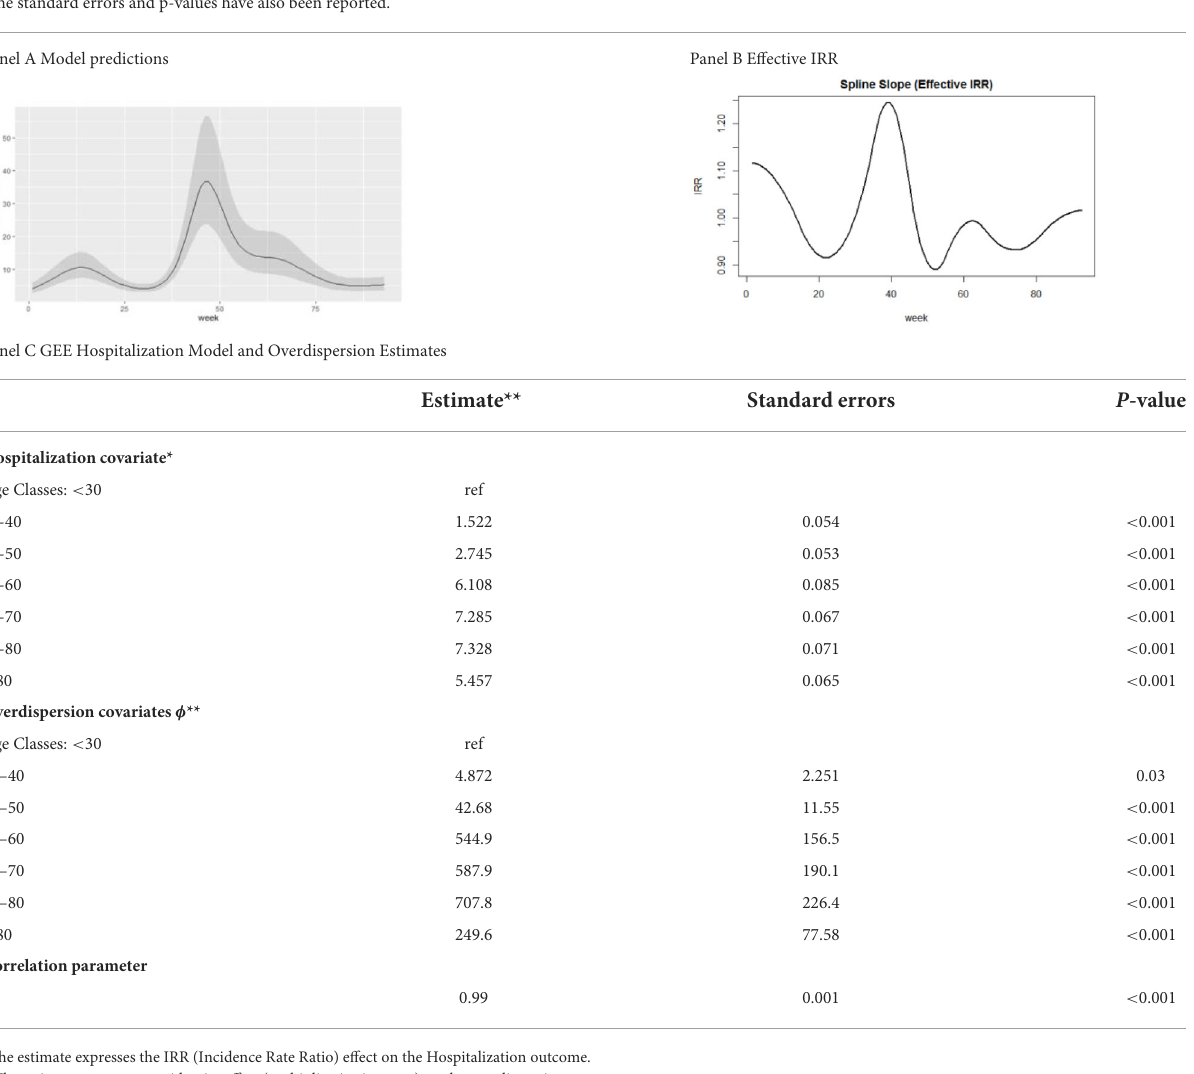
TABLE 3 GEE estimates. Panel A. Model predictions according to weeks with 95% confidence bounds. Panel B. Effective IRR (Incidence Rate Ratio) according to weeks. The varying IRR has been calculated by computing the first derivatives of predictions numerically and dividing the successive differences in predicted values by the successive variation in time unit (week). Panel C. The age effect on overdispersion has been reported ( φ ). The AR correlation structure minimizing the QIC and CIC criteria has been considered. The standard errors and p-values have also been